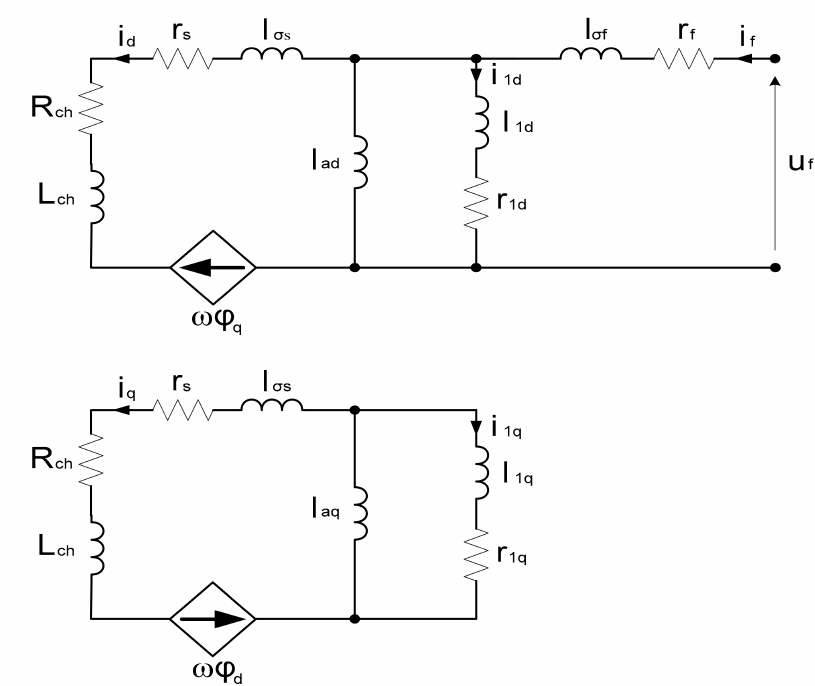
Figure 1. Classical integer order equivalent circuits of a synchronous generator connected to RL electric load (axes d and q